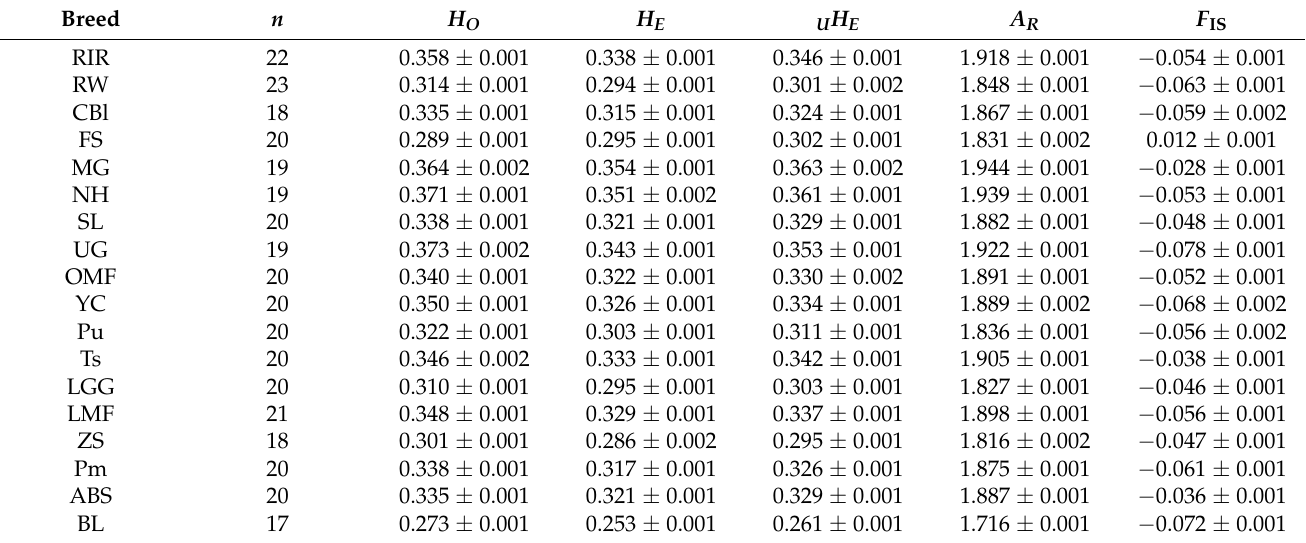
Table 2. Genetic diversity scores (M ± SE) based on SNP genotypes in the 18 studied chicken populations 1